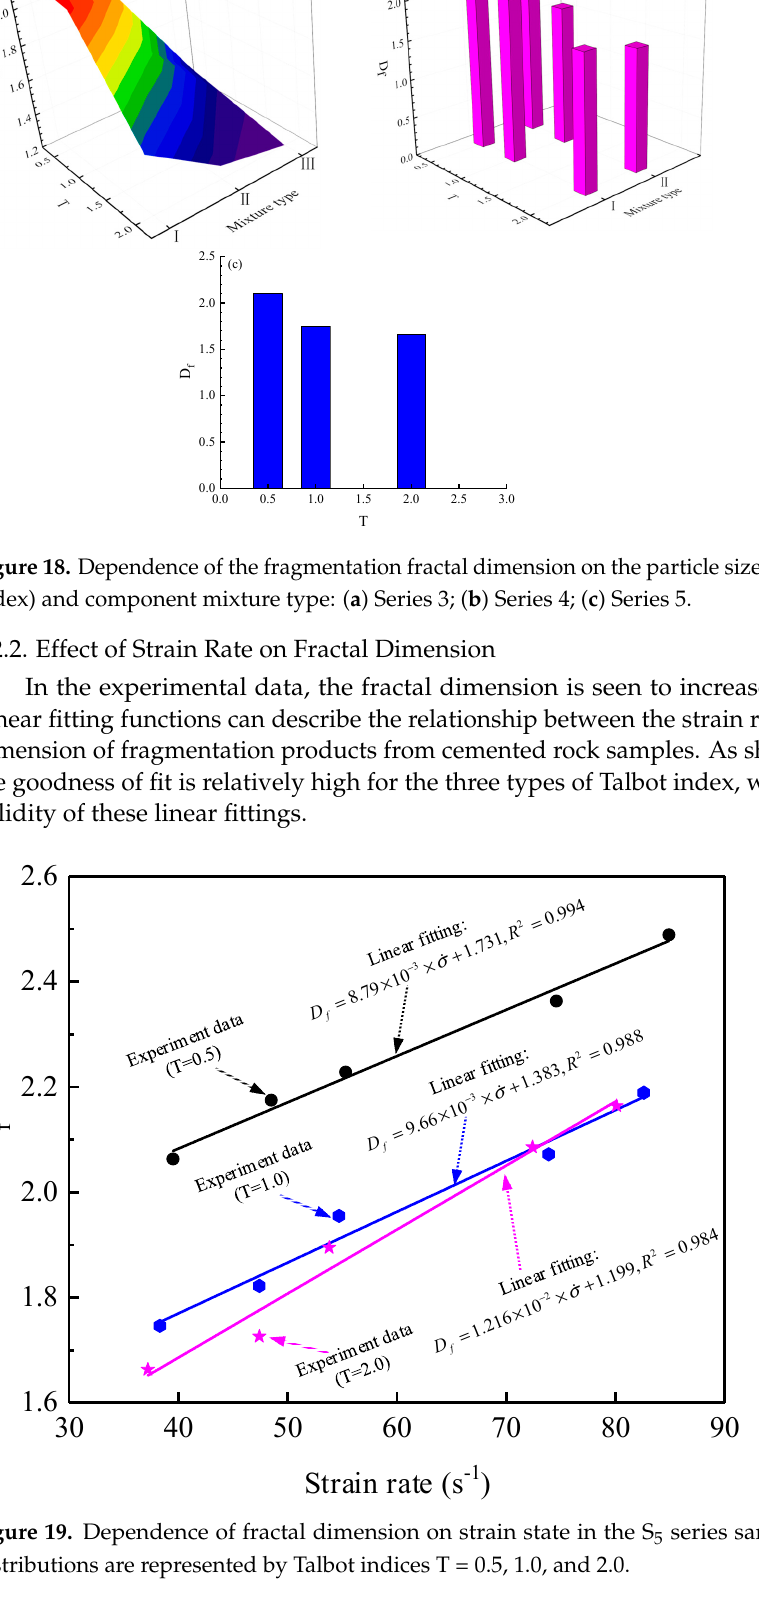
Figure 19. Dependence of fractal dimension on strain state in the S 5 series samples. Particle size distributions are represented by Talbot indices T = 0.5, 1.0, and 2.0.